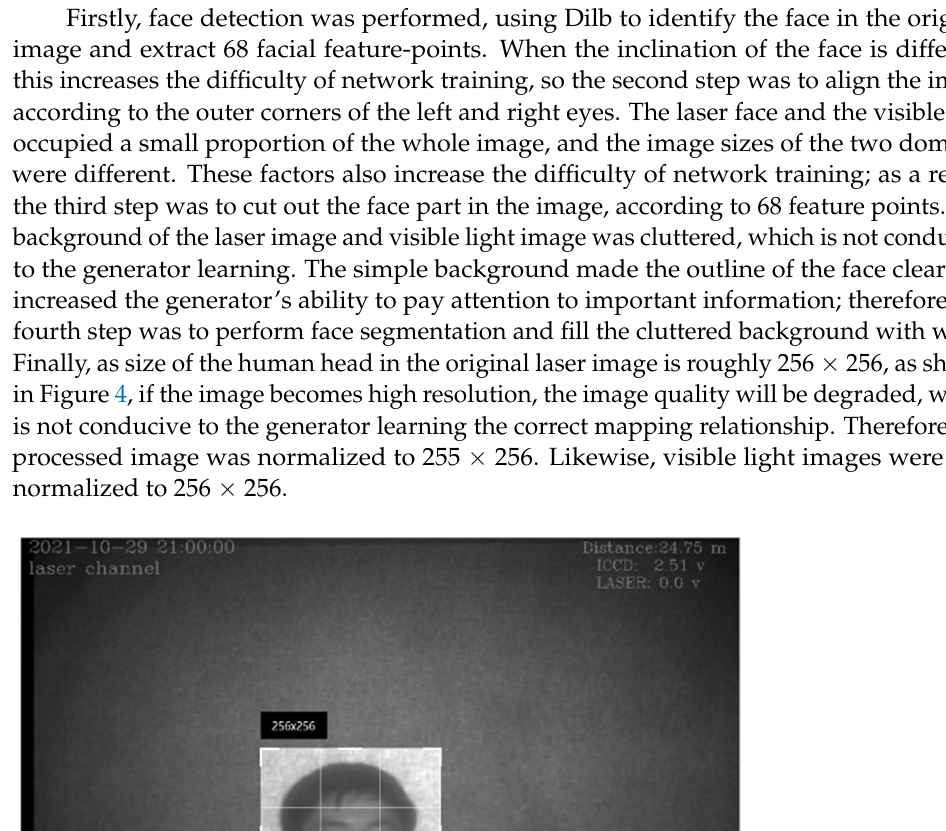
Figure 3. Acquired laser and visible images.